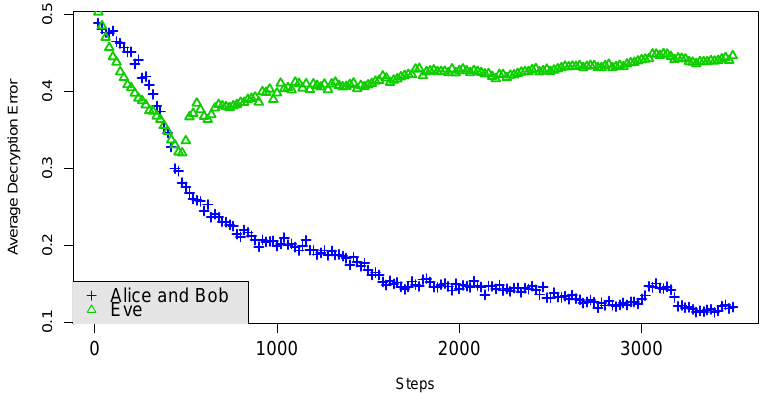
Figure 4. The learning curves forThe challenge between Alice and Bob against Eve who tries to minimize its decryption error. Alice and Bob try to minimize Bob’s decryption error while maximizing Eve’s decryption error. Eve is represented in green and Alice and Bob are represented in blue. The number of steps denote the number of “minibatches” on training phase.